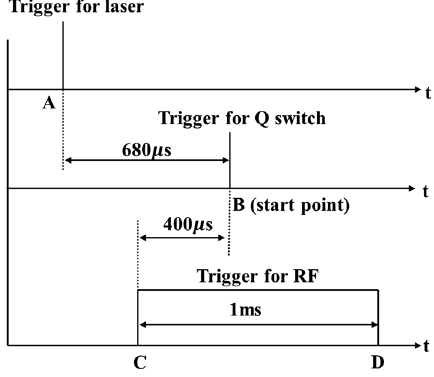
FIG. 12. The triggers from the SG1.